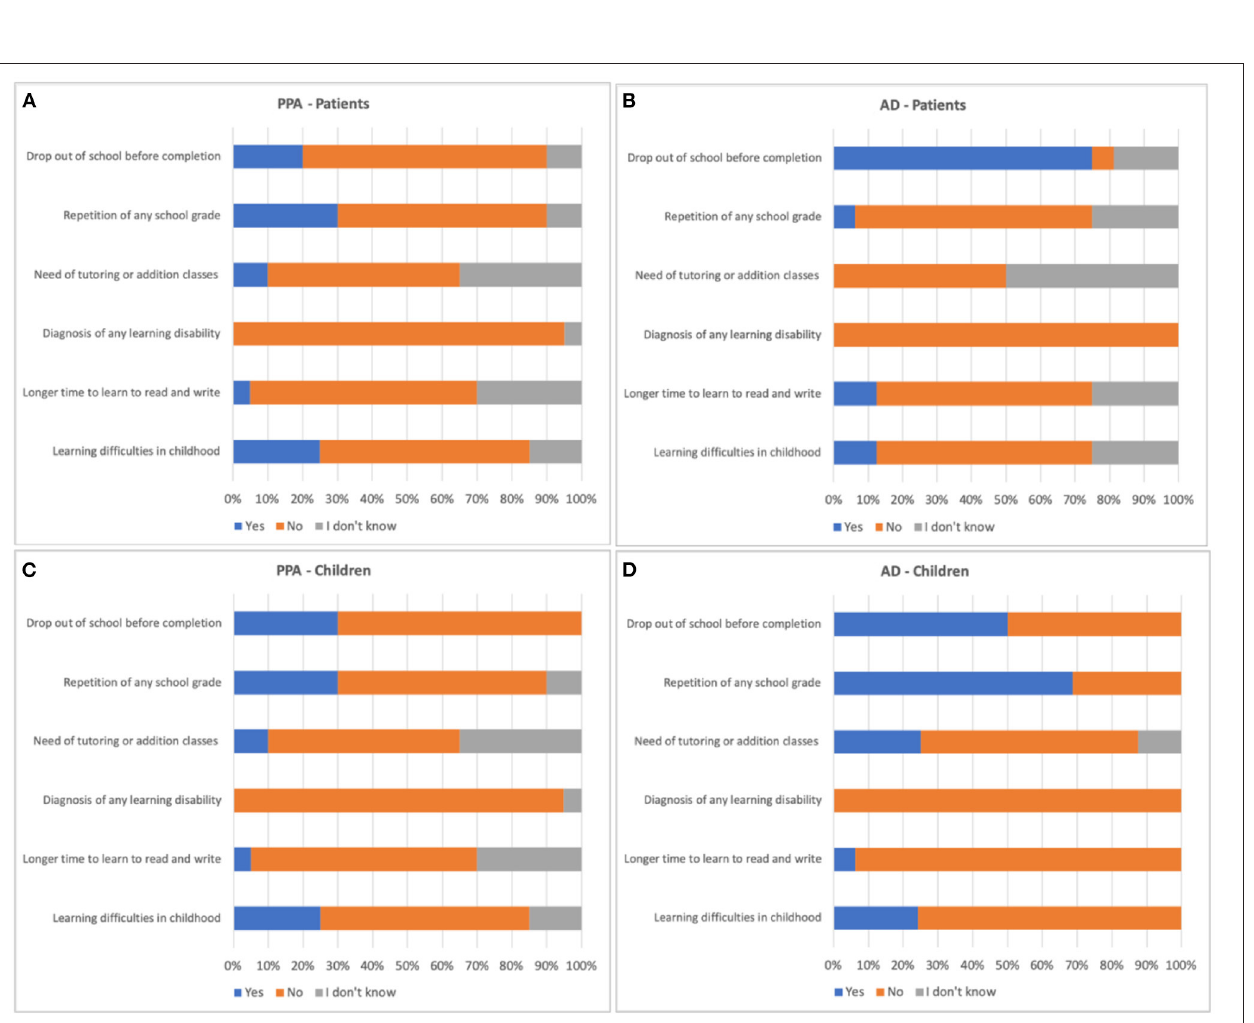
Frontiers in Neurology |